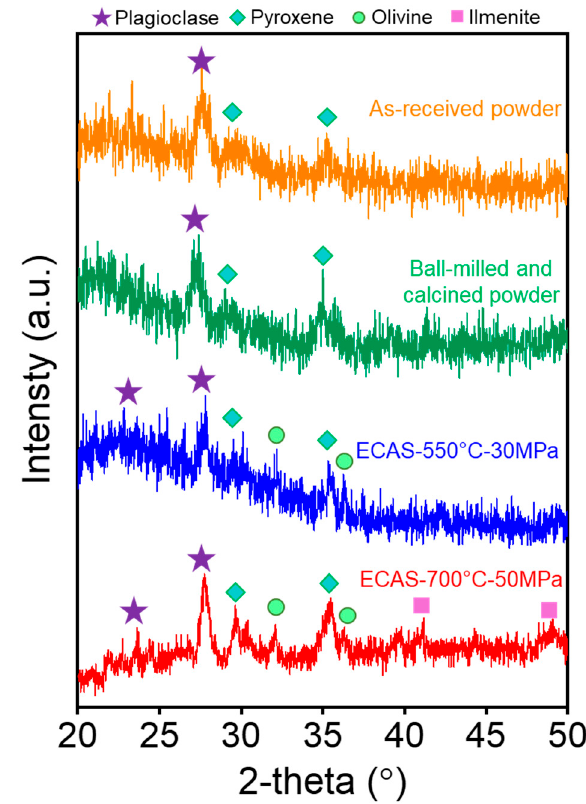
Figure 3. XRD pattern for the powder and sintered JSC-1A samples.